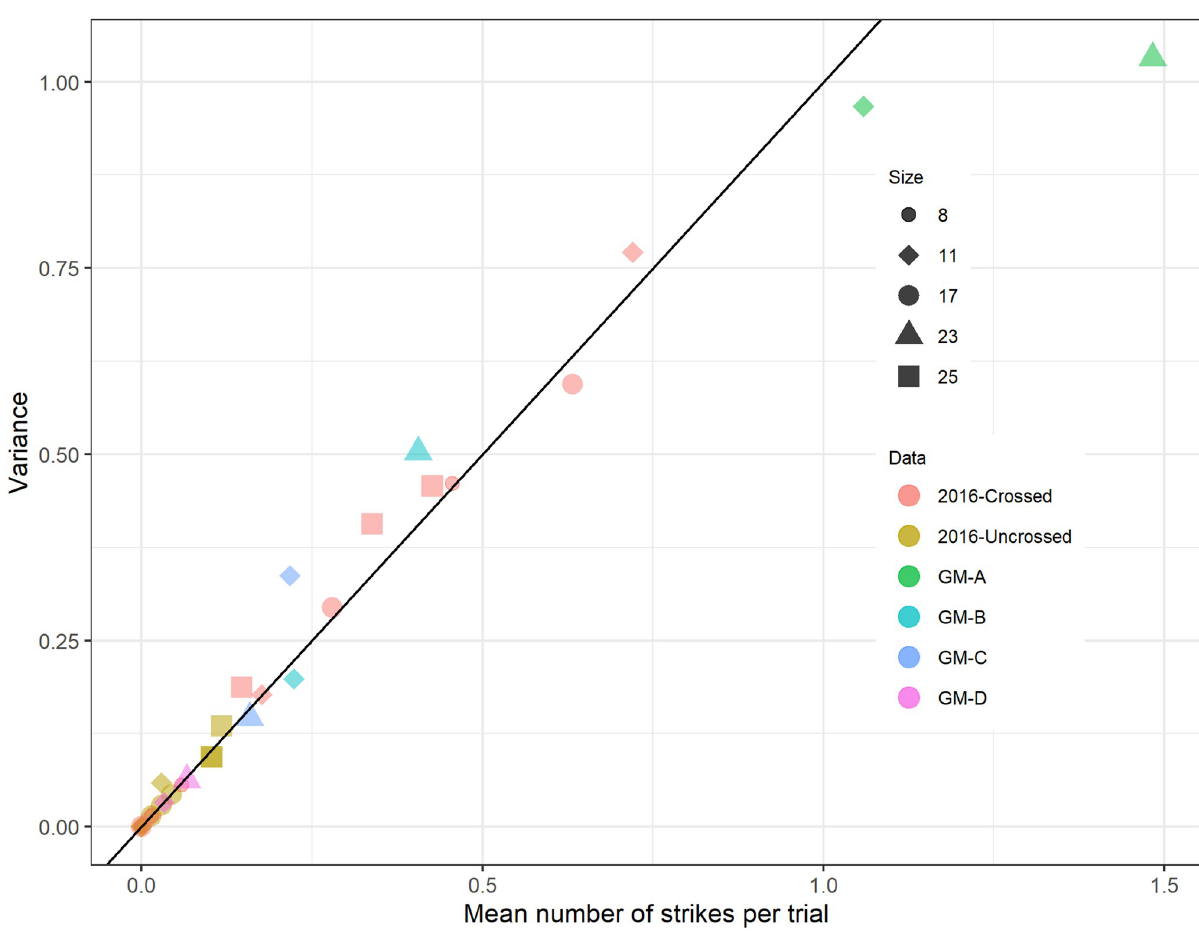
Fig 7. Variance versus mean for number of strikes per trial. Symbols labeled “2016-crossed/uncrossed” represent data from [10]; GM-A-D are from our ghost-match experiments, see Fig 10 below. We pooled data from all trials in all mantids for a given stimulus (disk size and geometry), and computed the mean and variance of the number of strikes observed across trials. The number of trials contributing to each data-point is 68 for the data from [10], 120 for the GM-D condition and 170 for GM-A,B,C. Symbols encode disk diameter in degrees; color encodes stimulus geometry and data- set. The scatterplot shows variance plotted against mean, with the black line marking the identity. For a Poisson distribution, variance = mean and so points should lie on the identity.